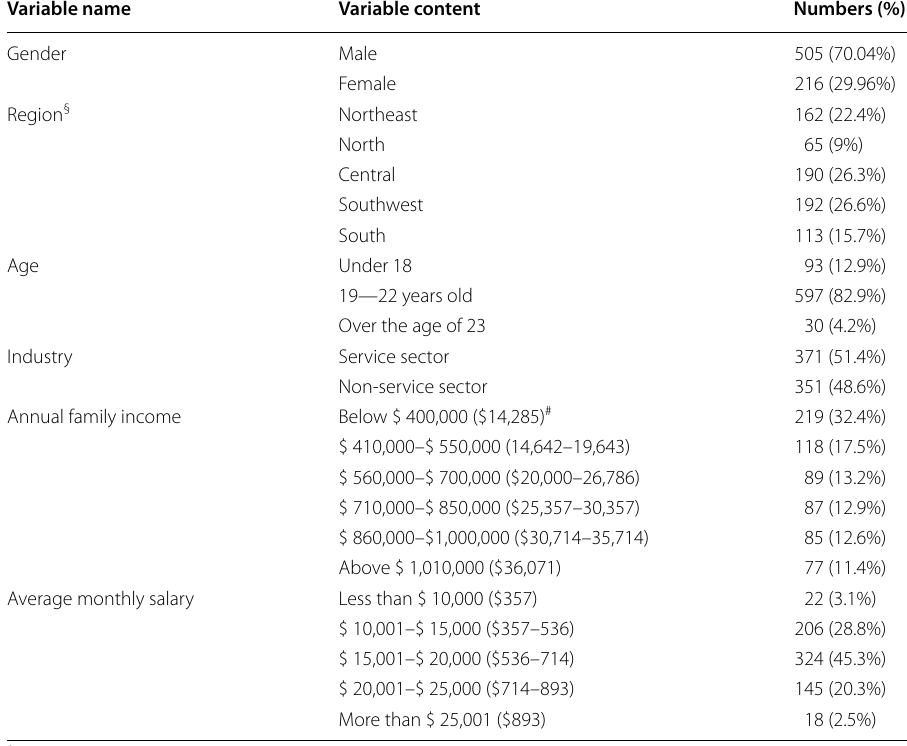
Table 1 Descriptive statistics of